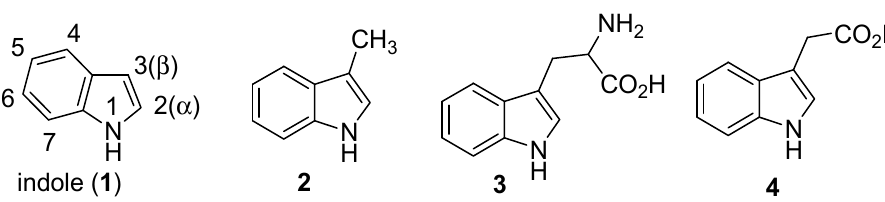
Figure 1. Indoles.